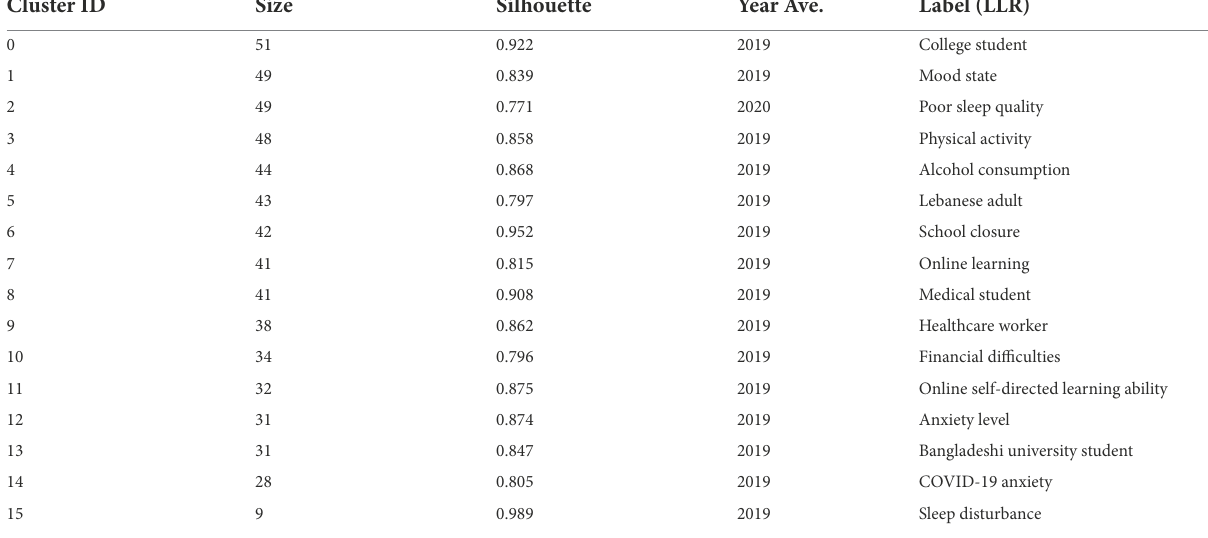
TABLE 4 Major clusters of co-cited